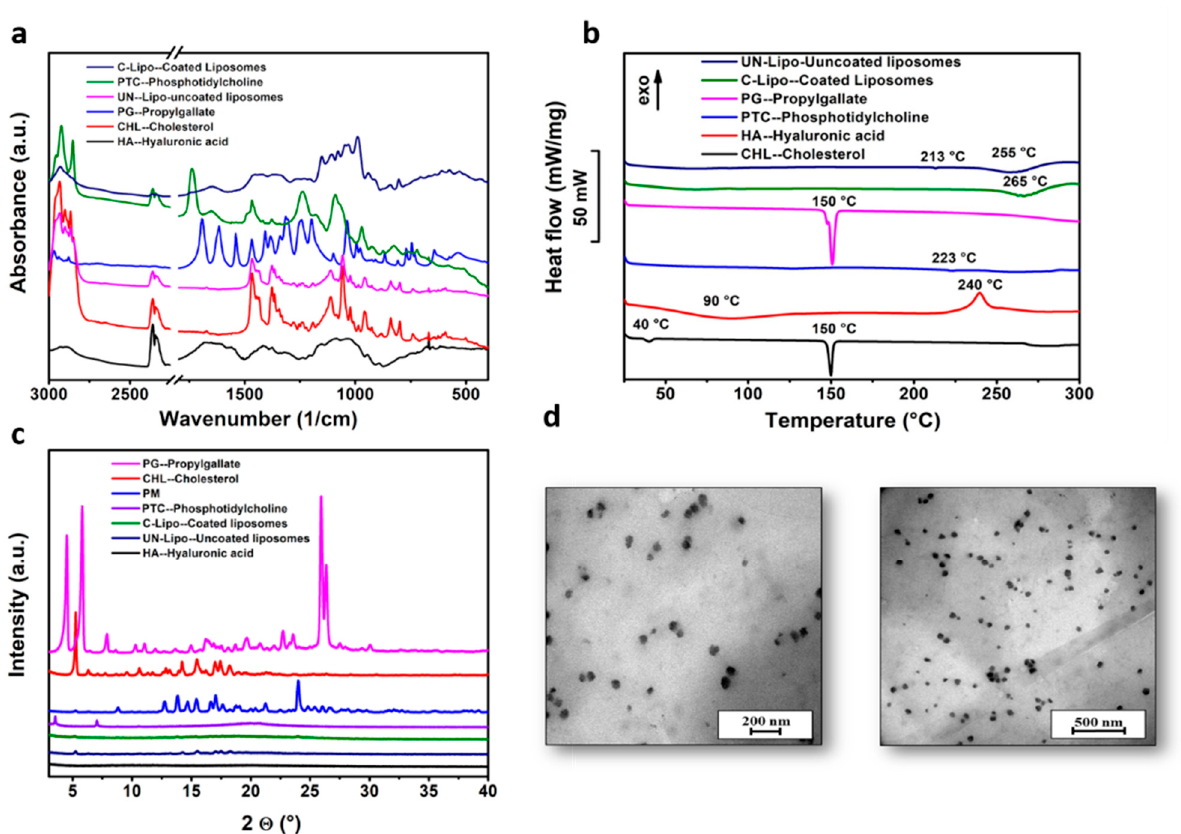
Figure 5. Fourier-transform infrared spectroscopy (FTIR) spectra ( a ), differential scanning calorimetry (DSC) thermograms ( b ), and X-ray powder diffraction (XRPD) diffractograms of coated and uncoated liposomes and components of liposomal formulation ( c ), and transmission electron microscopy (TEM) images of liposomes at different resolution scales ( d